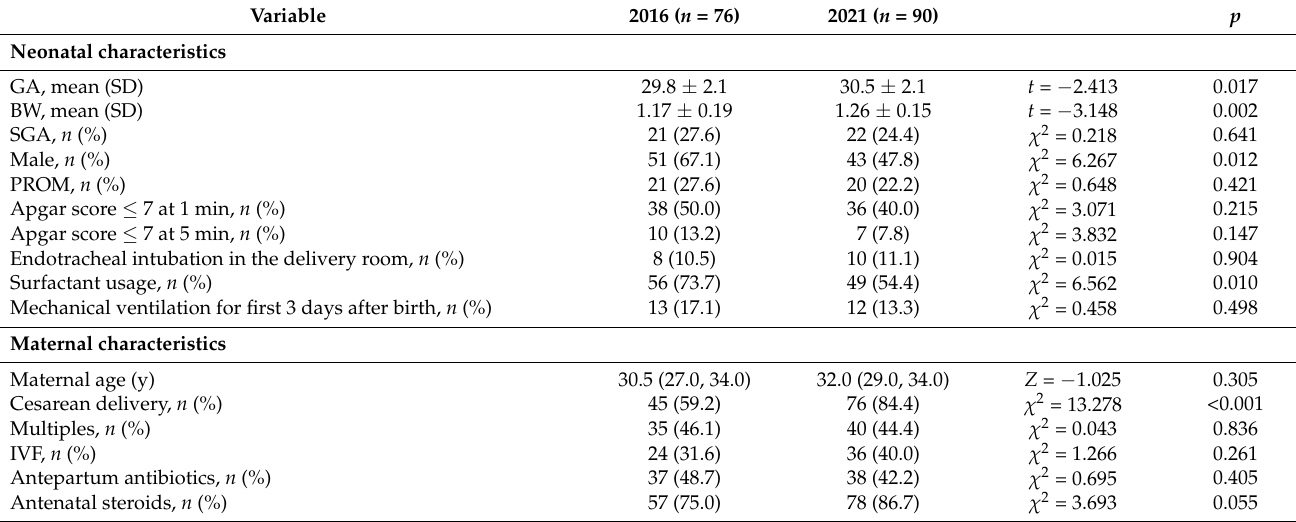
Table 4. Baseline perinatal characteristics of the 2016 and 2021 groups.